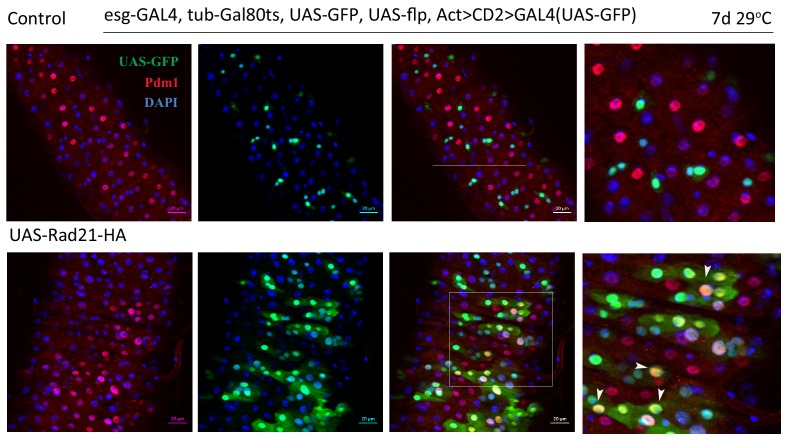
Esg-FlipOut (F/O) midguts expressing UAS-EYFP alone (control) or expressing UAS-Rad21-HA.Samples were stained for GFP and Pdm1. Differentiated cells are labeled with white arrowheads. Scale bars, 20 µm.